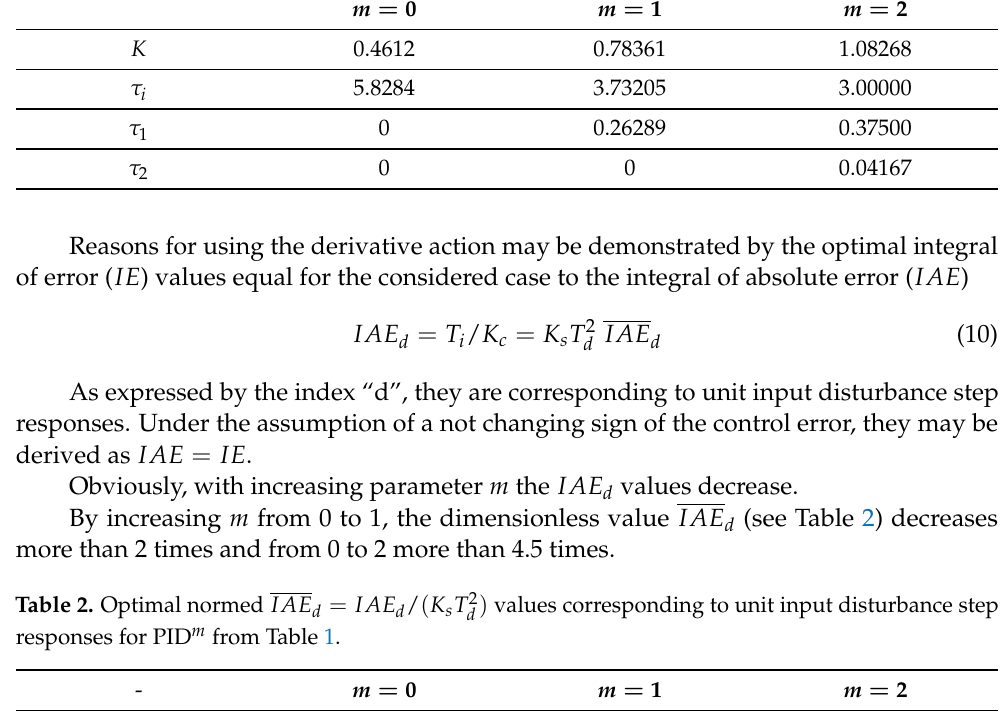
) values corresponding to unit input disturbance step d